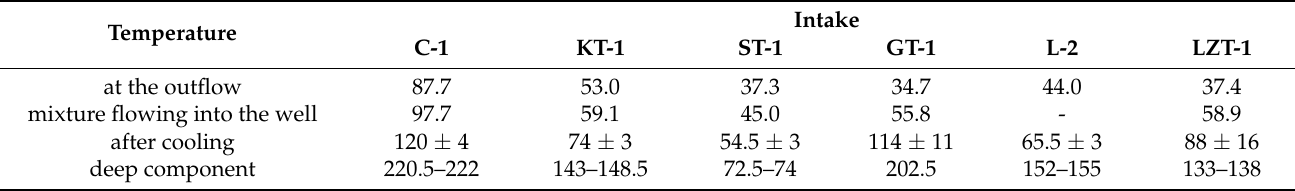
Table 5. An overview of the temperatures of thermal water deep components, their temperatures after cooling, and the temperatures of the mixture flowing into the well and out of the intake; temperature in ◦